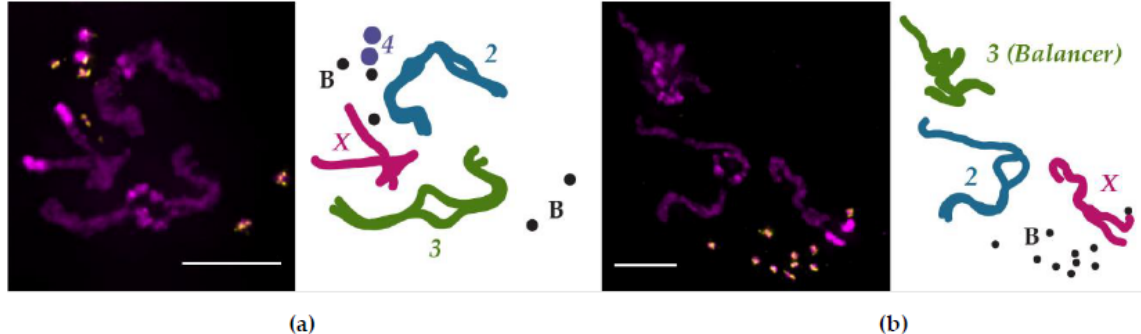
Figure 2. Homologous pairing in Drosophila melanogaster somatic cells that carry B chromosomes. ( a ) Tight homologous chromosome pairing between condensed chromosomes is retained primarily in the euchromatic regions. Left, metaphase chromosomes from third-instar larval neuroblasts; right, cartoon trace of each chromosome. The B chromosomes do not appear to pair. ( b ) Homologous chromosome pairing of a balancer chromosome (Chromosome 3), cartooned in green. The other large chromosomes exhibit normal pairing. Chromosome 4 not shown. Magenta: DNA, stained with DAPI. Yellow: fluorescent FISH probe recognizing the AAGAT satellite repeat present on Chromosome 4 and the B chromosomes. Scale bar = 5 µ m